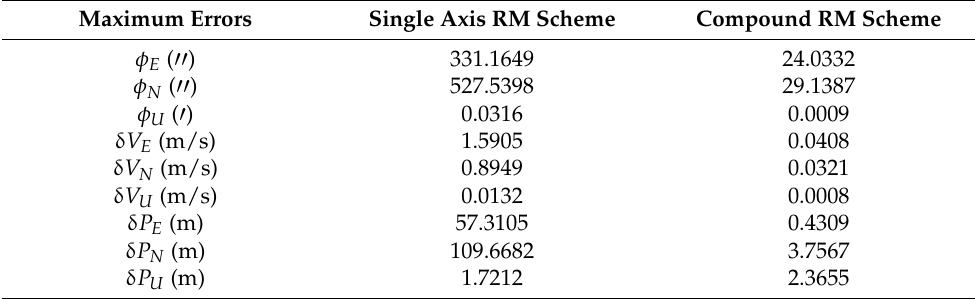
Table 6. Maximum errors between two rotational modulation schemes comparison.